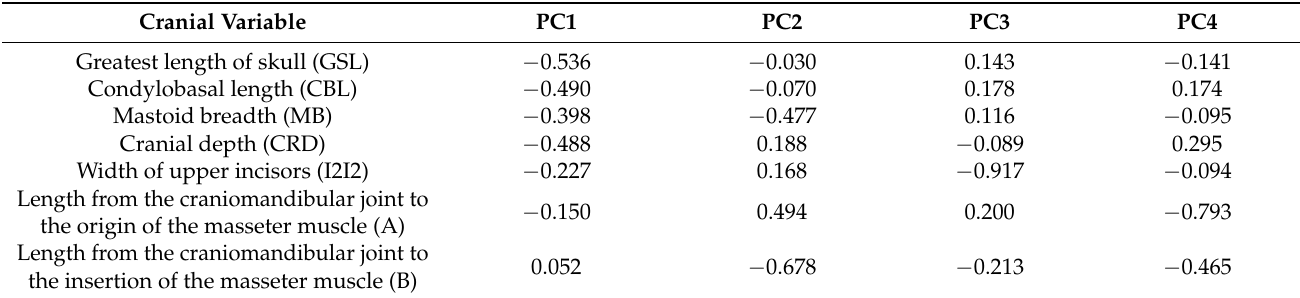
Table 2. Loadings for the first four components from a principal component analysis of seven cranial variables of Rhinolophus hipposideros (n = 31) from Italian populations collected between 1869 and 2002.